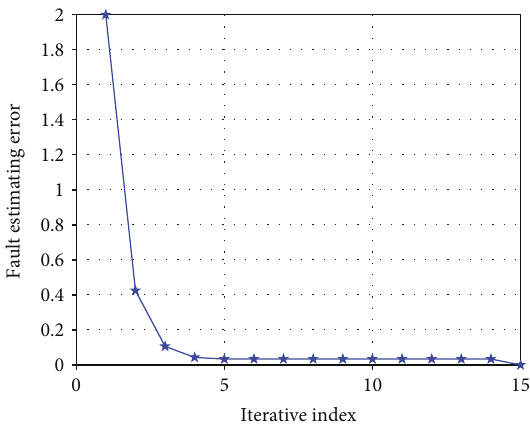
Figure 4: The tracking trajectory of abrupt fault for a nonlinear system with time-varying parameter